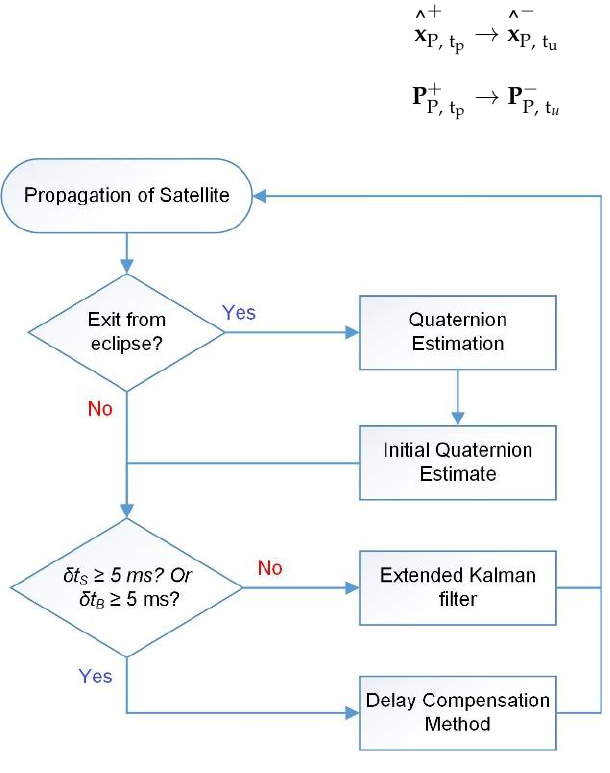
Figure 3. Algorithm flow diagram for delayed sensor scenario.